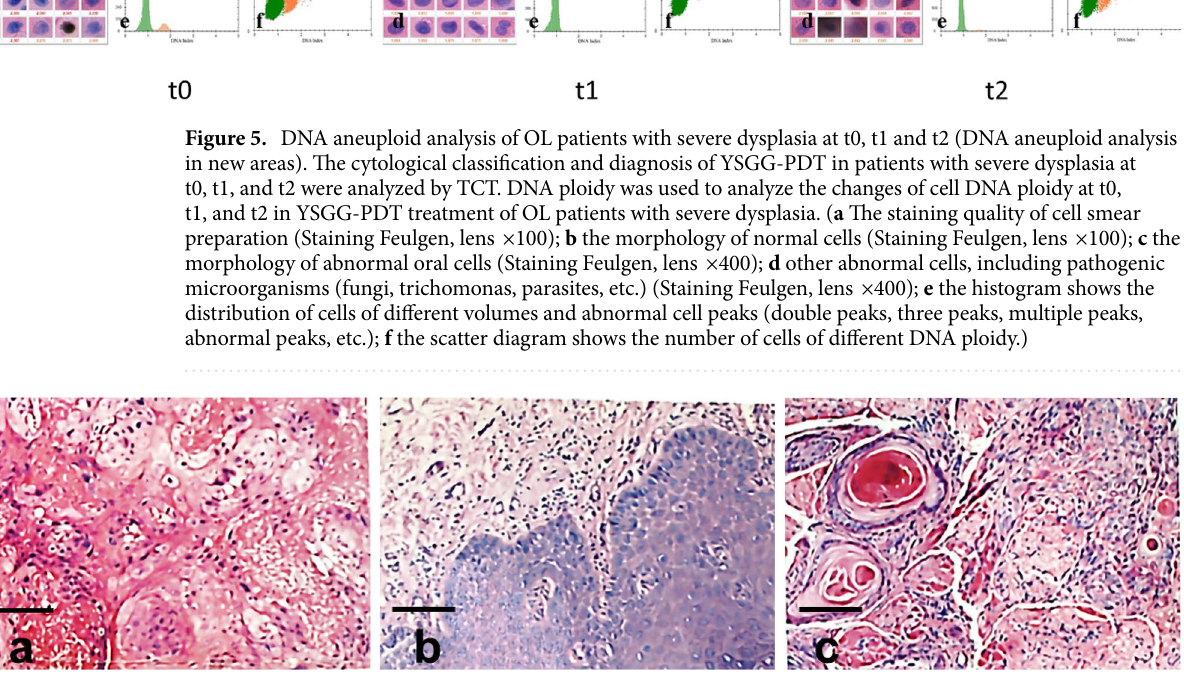
promising treatment method for achieving excellent outcomes for patients.